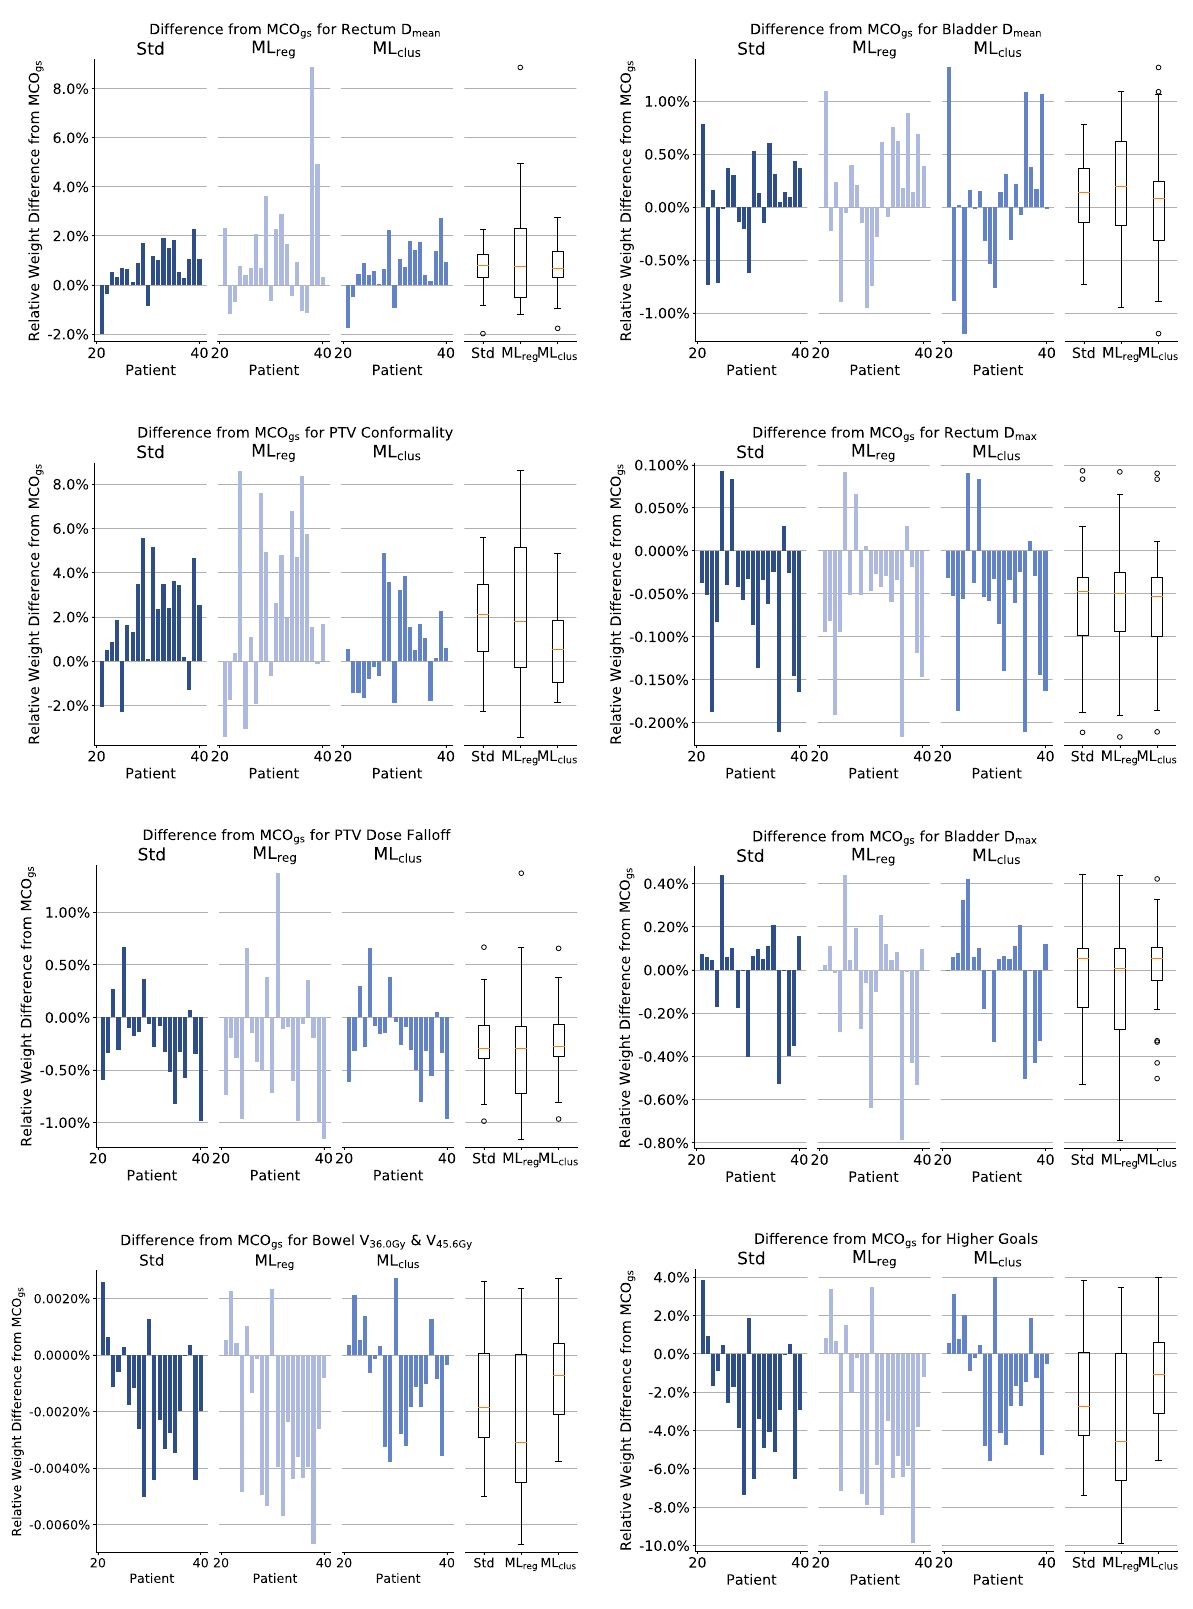
Figure 3. Plots showing relative weight difference from MCO gs for the validation dataset. Bar chart are order patient 21–40 and box plot represent the overall